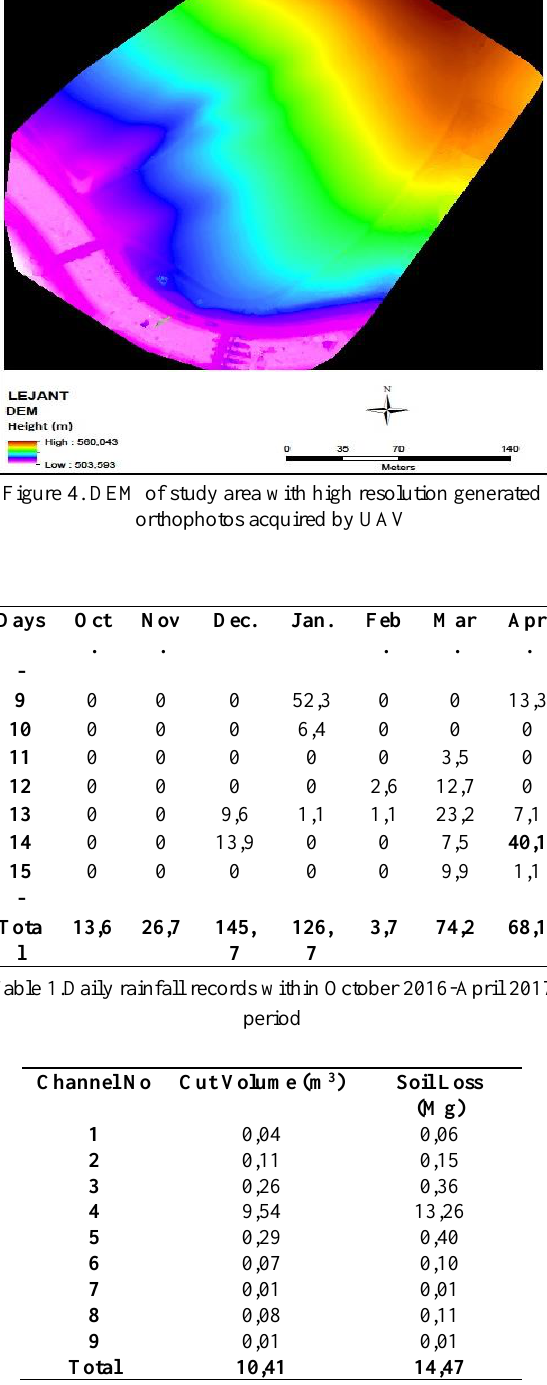
Table 2. Cut volume (m3) and soil losses (Mg) of some